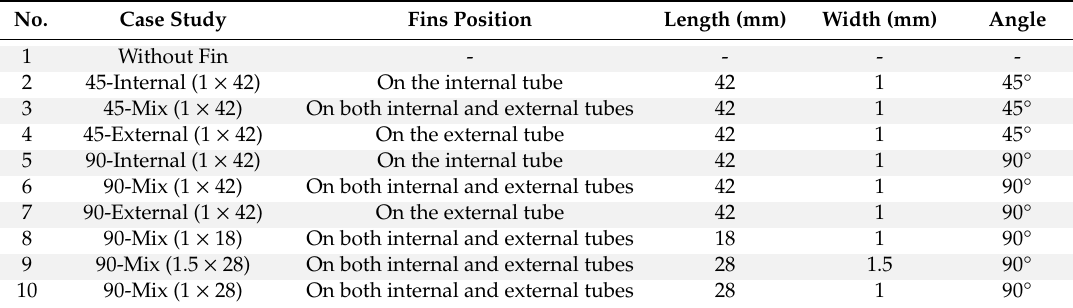
Table 2. The details of all case